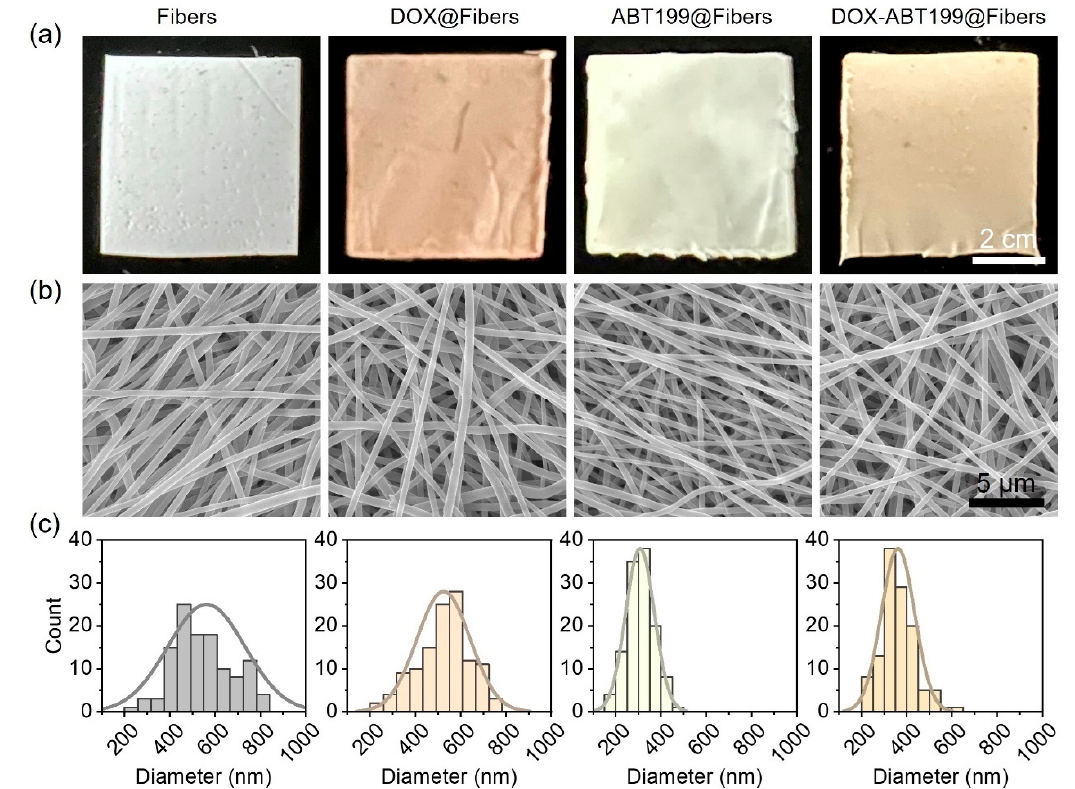
Figure 2. Characterization of the electrospun nanofibers loaded without and with drugs. ( a , b ) Digital and SEM images of Fibers, DOX@Fibers, ABT199@Fibers, and DOX-ABT199@Fibers, and ( c ) their corresponding diameter distributions extracted from the SEM images, respectively .